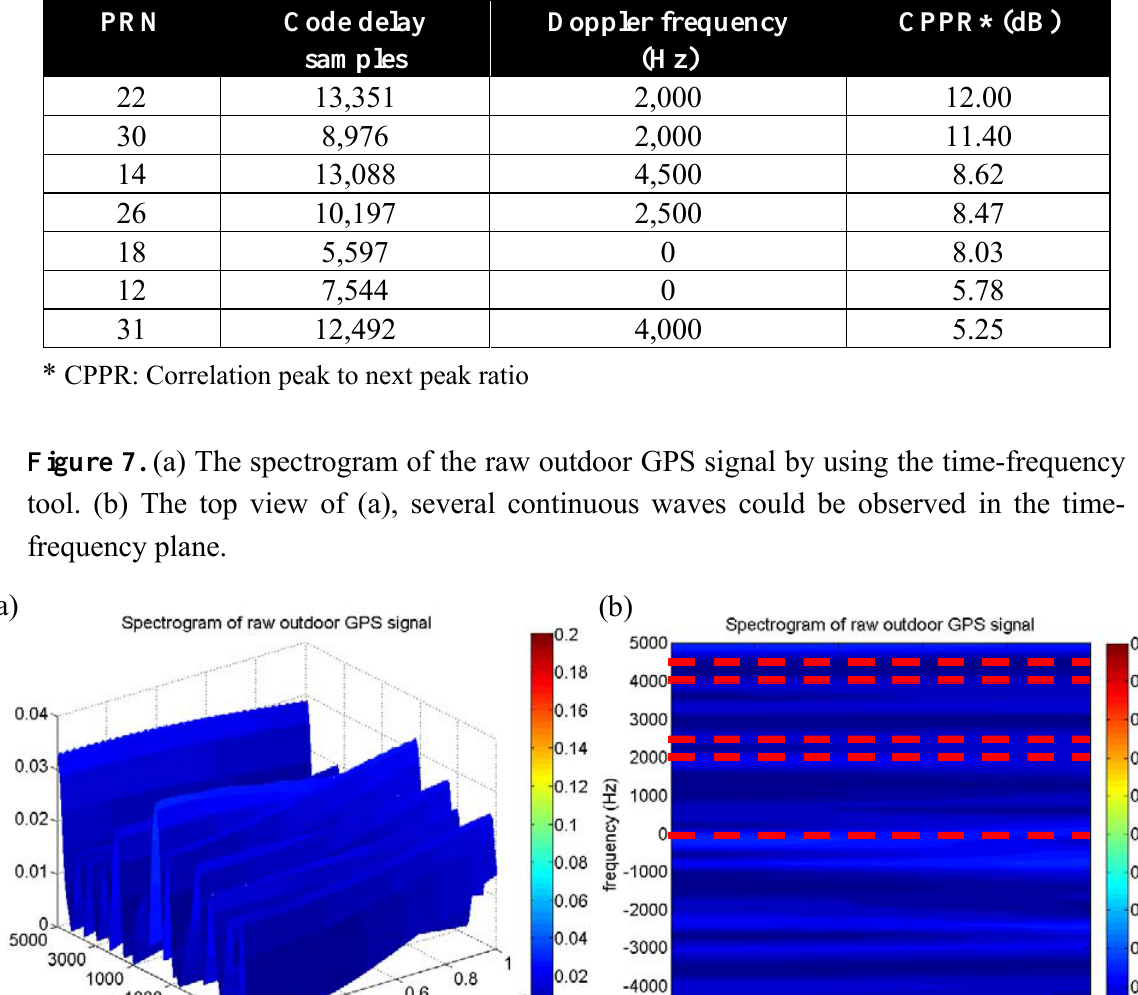
Table 1. The acquisition result of the collected outdoor GPS signal by the conventional acquisition method with the integration time of 1 millisecond.